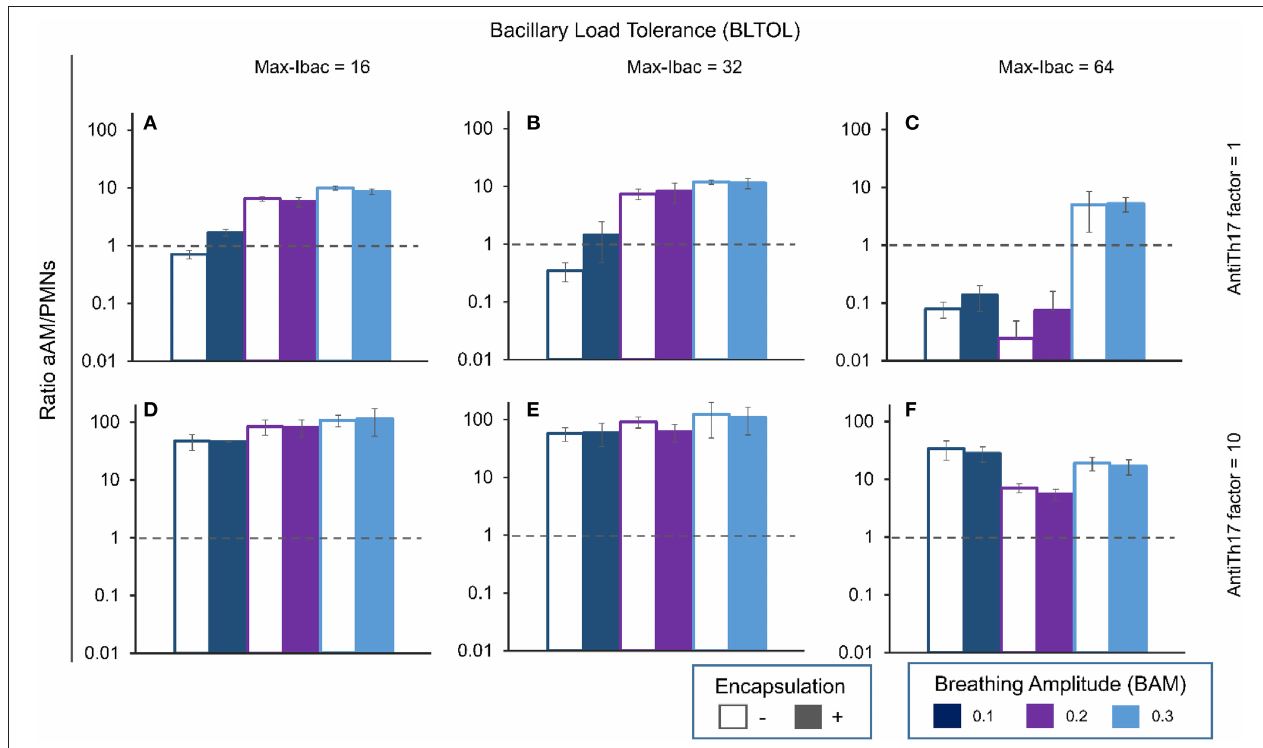
FIGURE 13 | Influence of different parameters on the ratio between aAMs and PMNs at day 42. Maximum bacillary load per macrophage (BLTOL): 16 (A,D) , 32 (B,E) , 64 (C,F) . AntiTh17 factor: 1 (A–C) , 10 (D–F) Encapsulation factor: − = no encapsulation, + = encapsulation. Breathing amplitude (BAM): 0.1, 0.2, 0.3. Bars indicate the mean of 10 runs. Horizontal dotted lines correspond to ratio 1 (ratio > 1 corresponds to aAM > PMNs, and ratio < 1 corresponds to aAM <